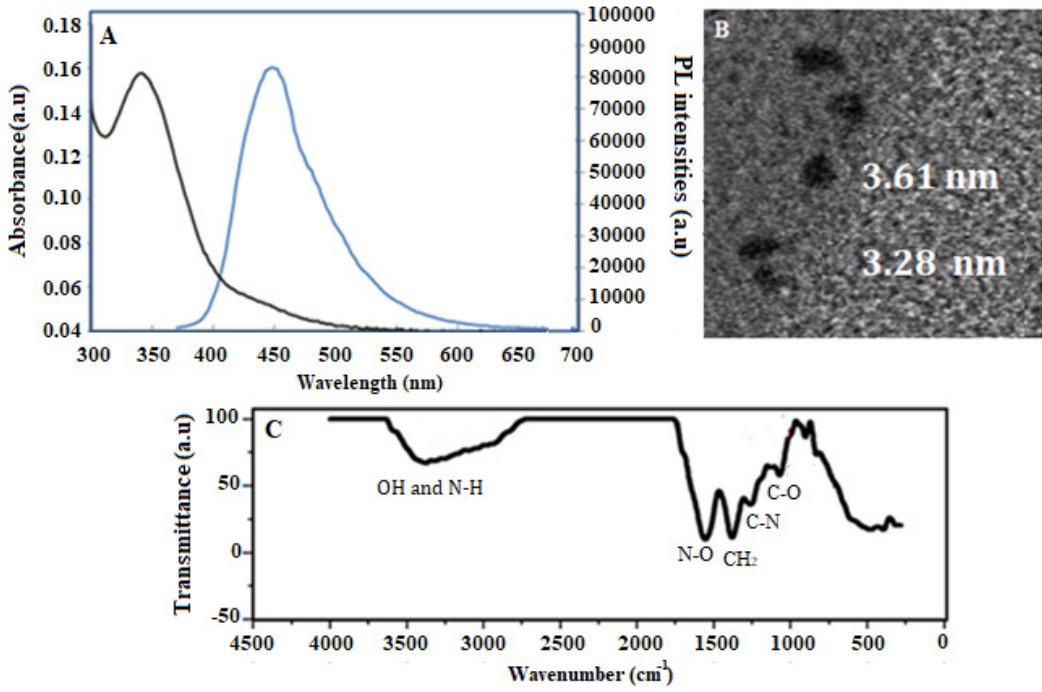
Figure 1. ( A ) UV-Vis absorption spectrum and fluorescence spectrum of CDs; ( B ) TEM images of CDs; ( C ) FTIR spectra of CDs.